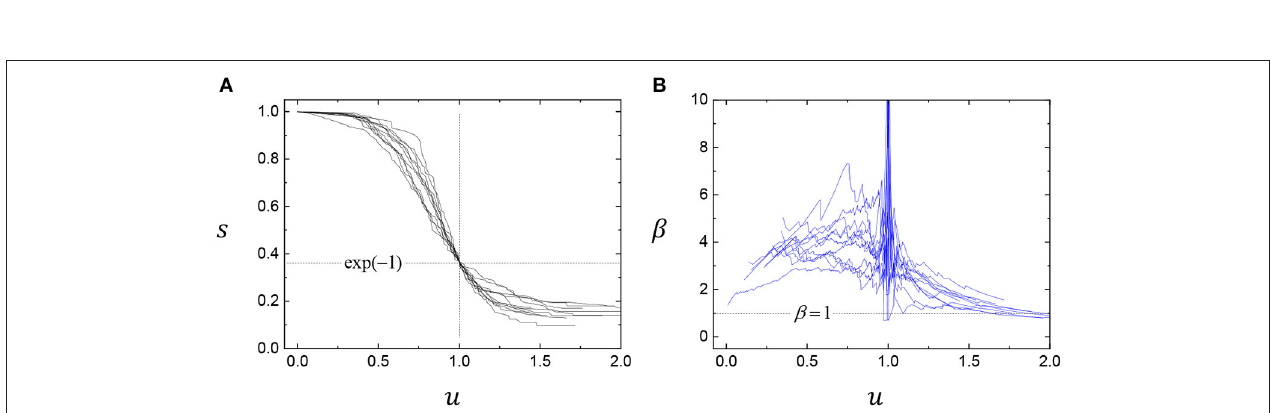
FIGURE 4 | Nonexponentiality of survival curves in clean foams. (A) The survival curves of clean foams (from Figure 1B ) are analyzed by the modified stretched exponential function, s ( u ) = exp( − u β ( u ) ), where the rescaled age u = x /α is relevant to the characteristic life ( α ) at s ( α ) = exp( − 1) and the stretched exponent β ( u ) is age-dependent. (B) The age-dependence in β ( u ) is a typical feature found in biological aging [24, 25].